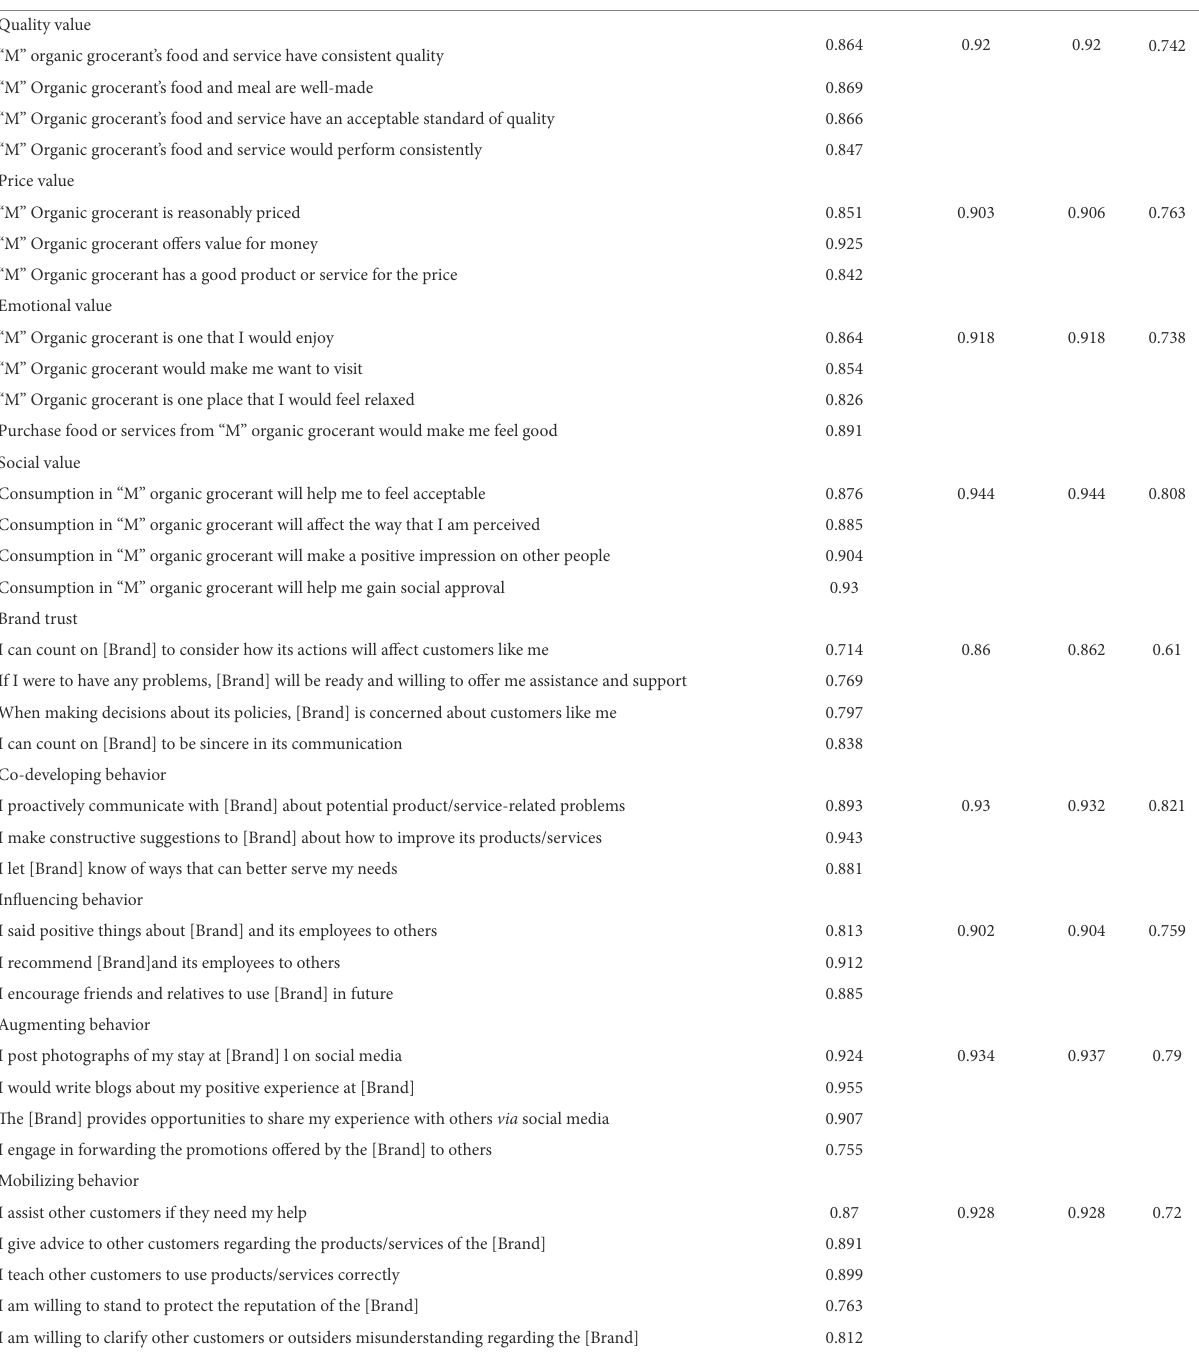
TABLE 1 CFA results in the survey.